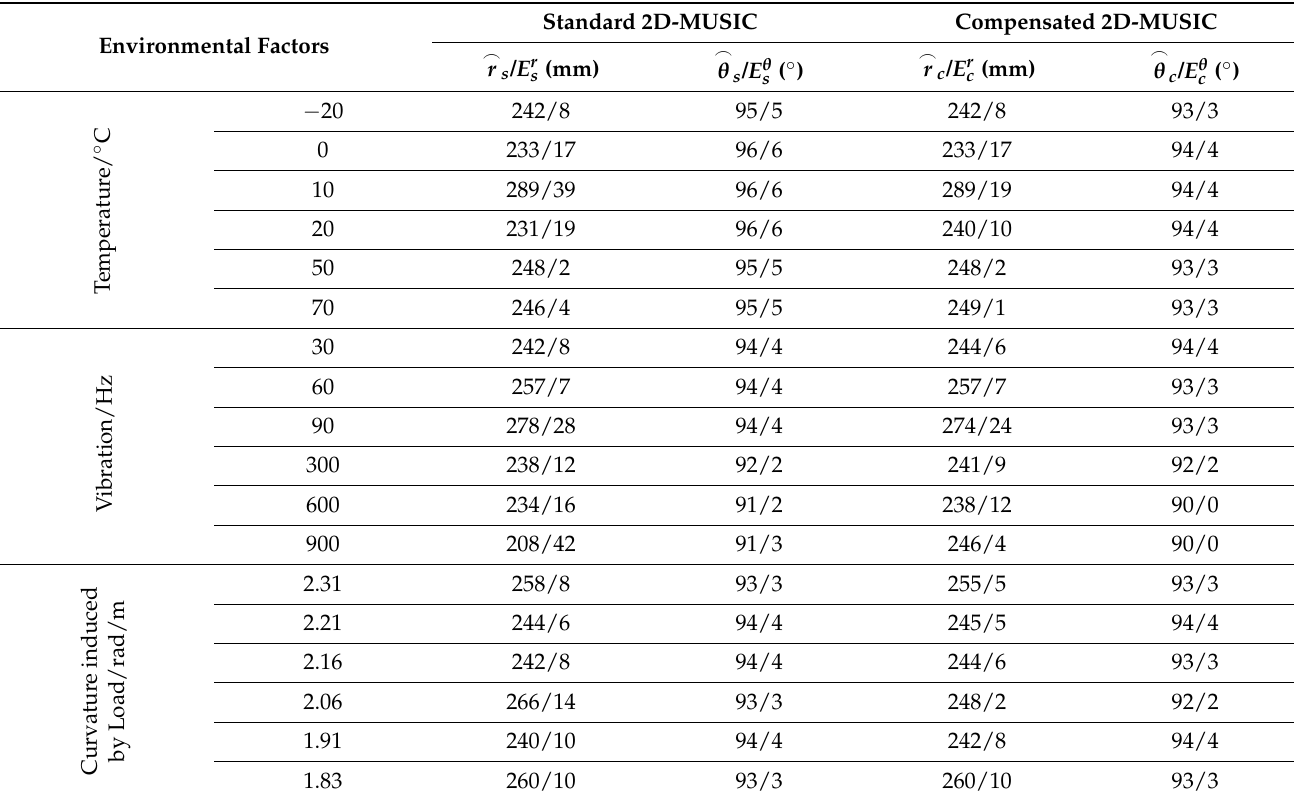
Table 1. Localization results under environmental conditions using the standard and compensated 2D-MUSIC. Environmental